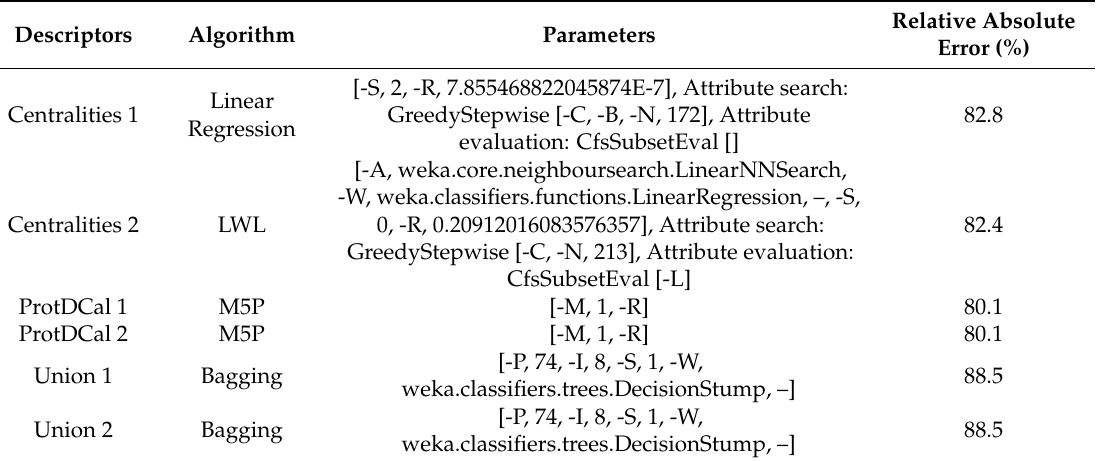
Table 4. Algorithms and parameters optimized for